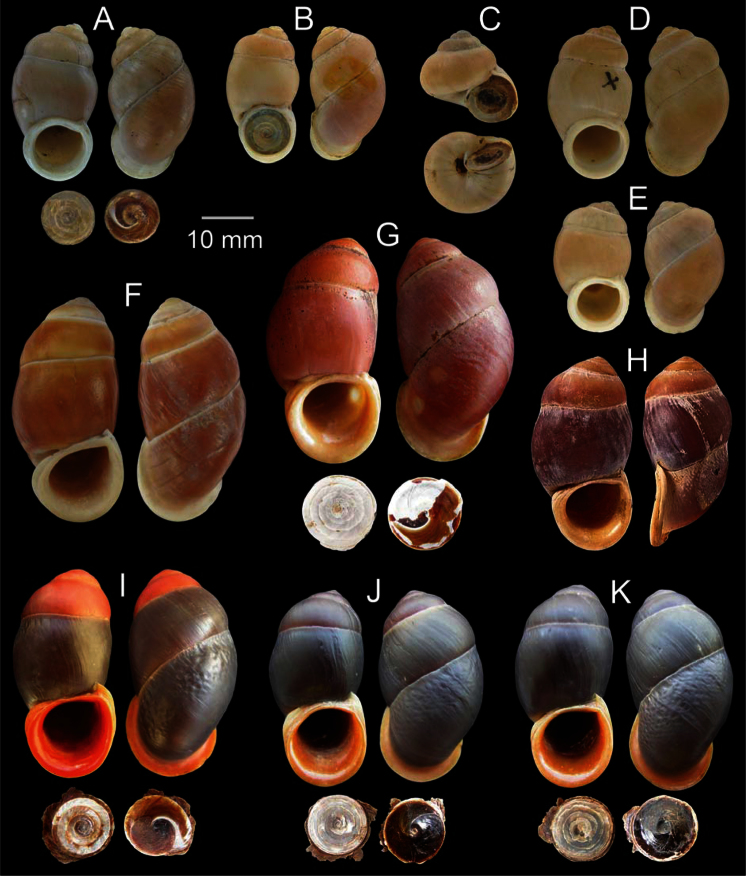
Shell morphology of Pollicaria spp. A–E
Pollicaria gravida
A lectotype UMZC I.102935.A B paralectotype UMZC I.102935.B-E C syntype of Otopoma blennus Benson, 1856 UMZC I.102930.A and D, E specimens from Farm Caves, Moulmein, Burma (NHMUK 88.124.863.4–5; specimen with ‘x’ was figured in Gude (1921), fig. 29) F, G Pollicaria myersii
F form Siam (NHMUK 20090242; specimen figured in Pfeiffer, 1856a, pl. 19, figs 1, 2), and G specimen from Pahom, Vang Vieng, Laos (CUMZ 1572) H, I
Pollicaria mouhoti mouhoti
H lectotype (NHMUK 20130071/1), and I specimen from Tam Wungdang, Phitsanulok (CUMZ 1533) J, K
Pollicaria mouhoti monochroma ssp. n. from the type locality, J holotype CUMZ 1577, and K paratype CUMZ 1548.